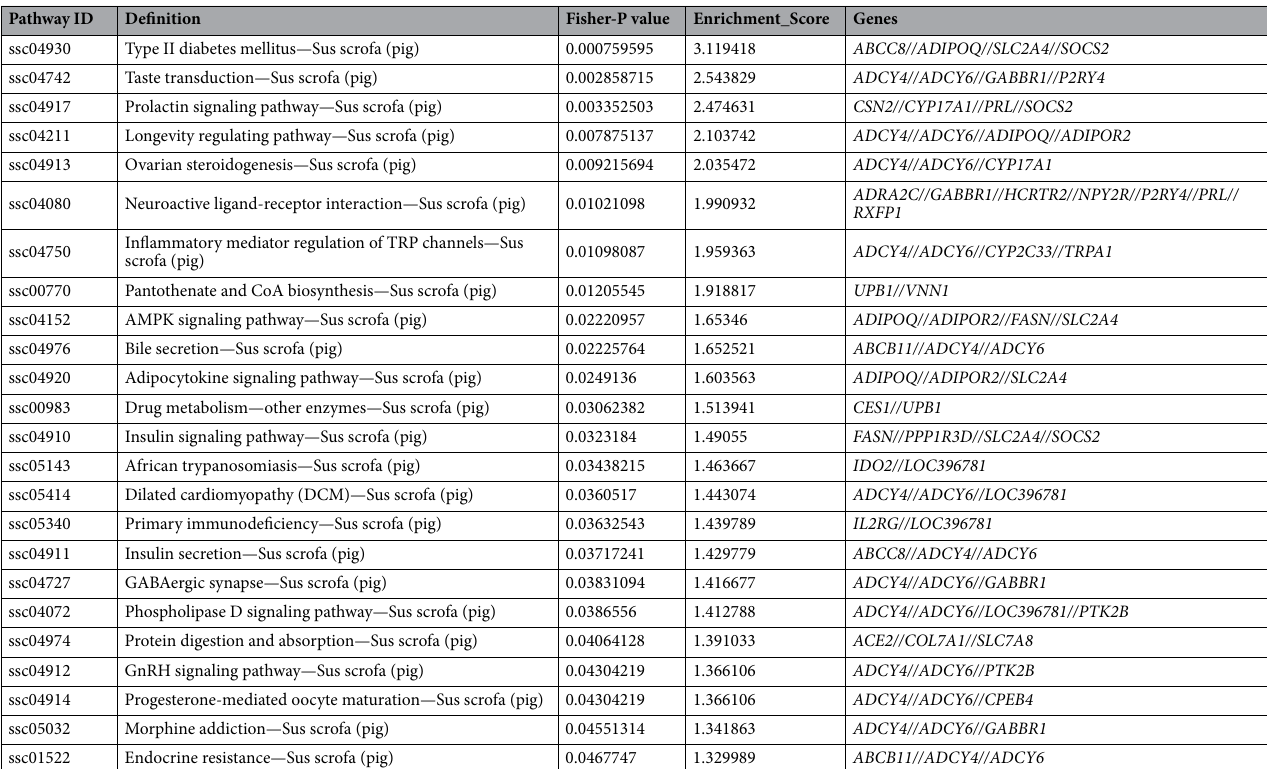
Table 9. The pathways with up-regulated gene enrichment scores.